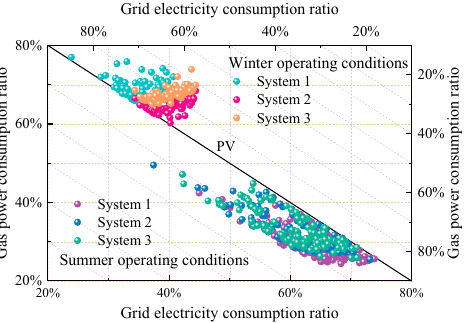
Figure 12. Different power consumption ratios under two operating